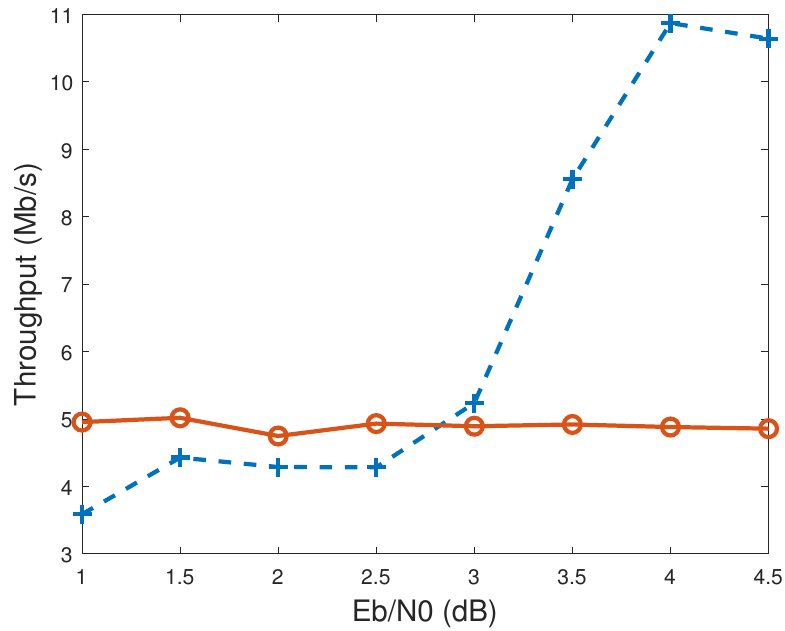
Figure 8. Throughput of different SNR values for RS and Polar